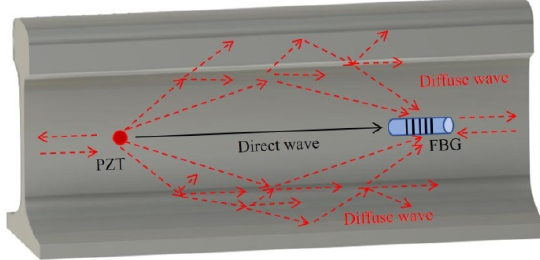
Figure 5. Schematic illustration of ultrasonic wave field on rail.